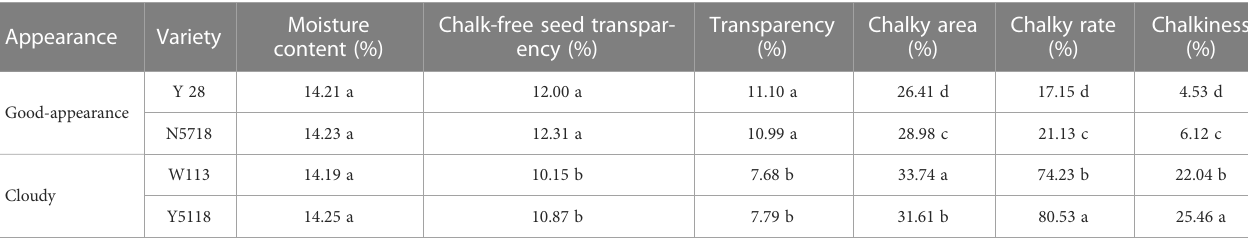
Chalk-free seed transpar- ency (%)